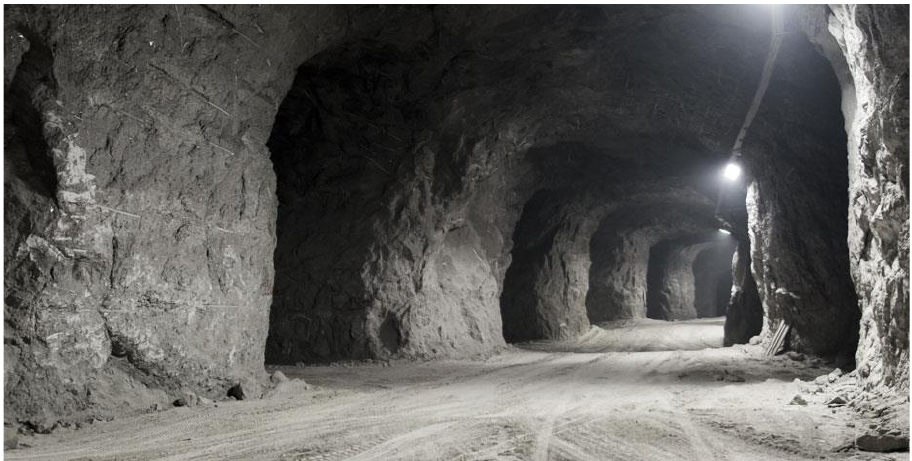
Figure 2. A view of the inside of the Murisengo Underground Quarry with abandoned rock pillars and